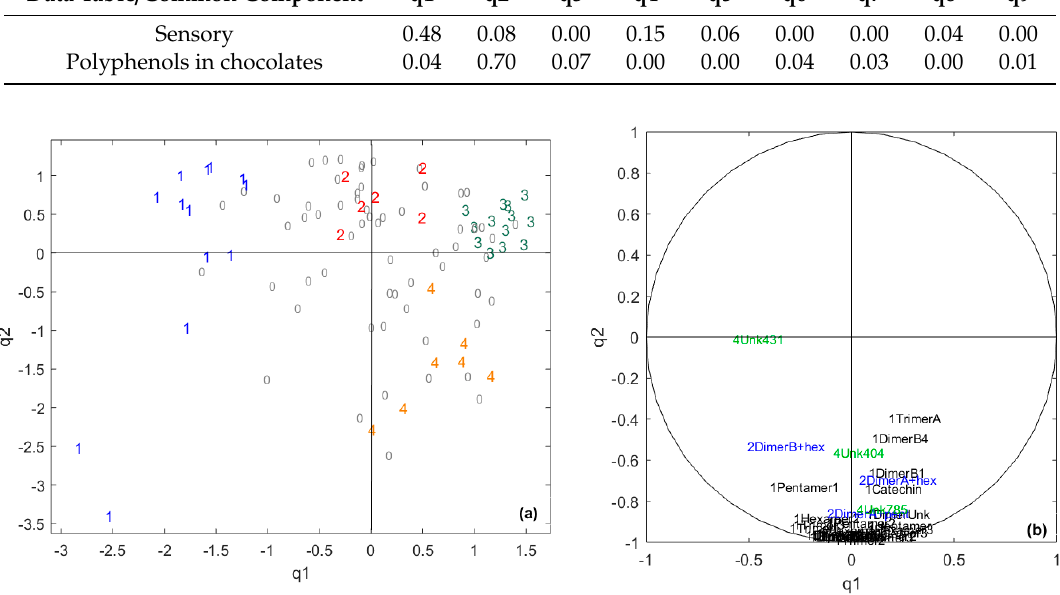
Figure 1. Projection of the samples on the first two scores of the principle component analysis (PCA) performed on centered sensory data. Sensory pole cores are coded from 1 to 4 with different colors: 1 = core pole 1, 2 = core pole 2, 3 = core pole 3, 4 = core pole 4 and 0 = samples not belonging to any core pole. Table 1. Values of the specific weights (%) of each component (q1 through q9) calculated by the Common Component and Specific Weights Analysis (CCSWA) with chocolate polyphenolic data and sensory data. Data Table / Common Component